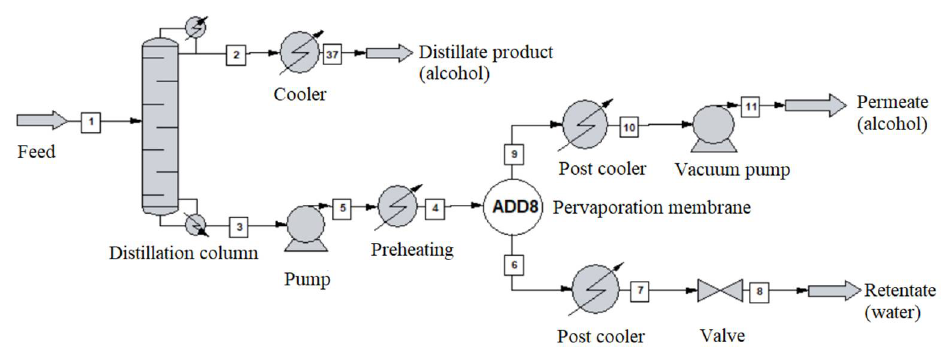
Figure 7. Flowsheet of hybrid distillation-organophilic pervaporation method.